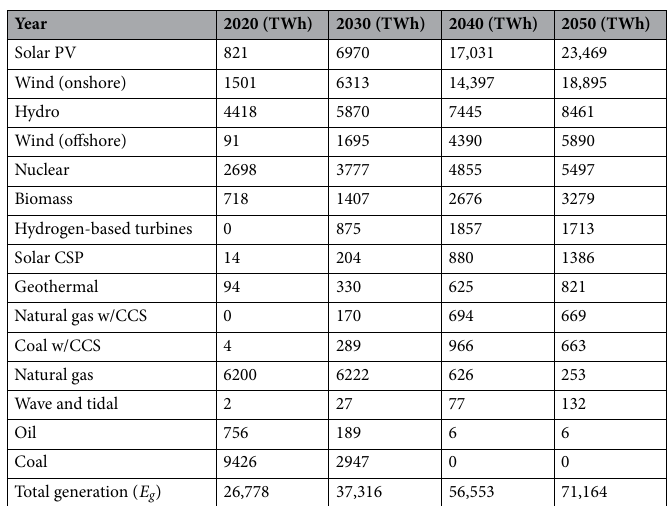
Table 19. Predicted electricity generation based on the net-zero target toward 2050 (IEA NZE) 22 , assuming more than 20% of wind installations from 2021 to 2050 to be sea-based installations 22 , and 25% of the added wind energy generation (i.e., higher capacity factor).